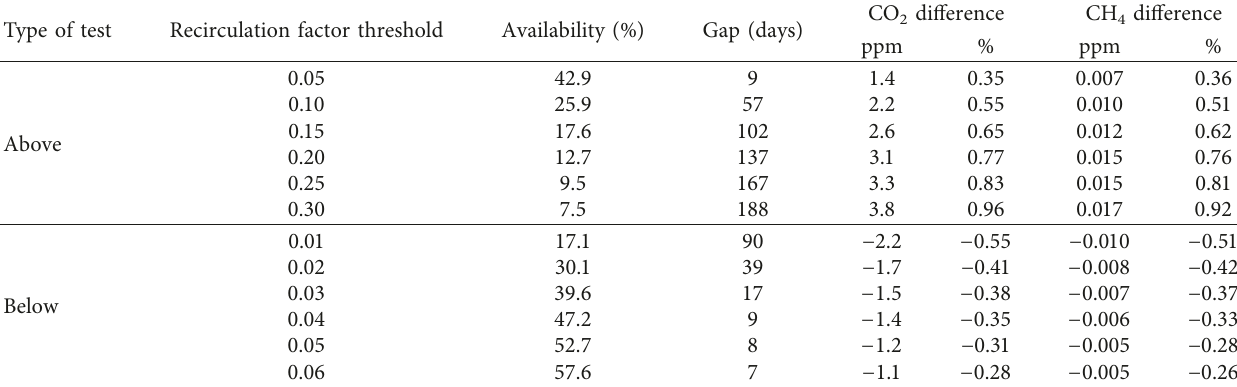
Table 5: Differences between average concentrations calculated with observations selected for thresholds and the annual cycle for nighttime observations. Availability of frequencies and number of days without observations (gaps) are also presented. Type of test